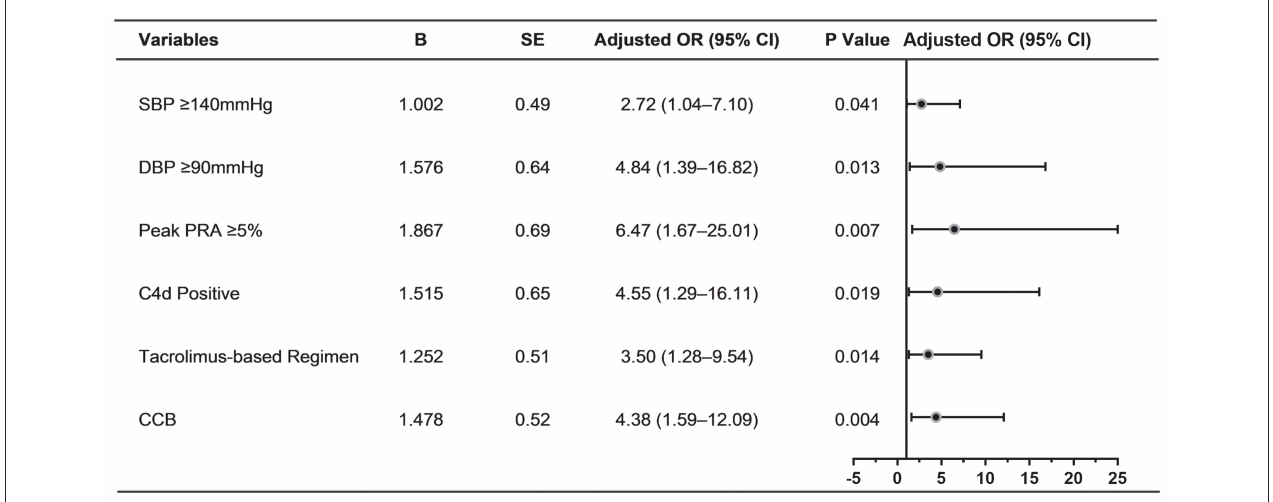
FIGURE 4 | Determinants of proteinuria in multivariable logistic regression analysis ( n = 165). Forest plot displaying odds ratios for proteinuria after multivariable logistic regression analysis. The following variables were included in the multivariable model: Peak PRA ≥ 5%, delayed graft function, SBP ≥ 140 mmHg, DBP ≥ 90 mmHg, CNI regimens, use of ACEI/ARB, use of CCB, positive C4d staining, cg score ≥ 2. SE, standard error; OR, odds ratio; CI, confidence interval; SBP, systolic blood pressure; DBP, diastolic blood pressure; PRA, panel reactive antibody; CCB, calcium channel blocker; CNI, calcineurin inhibitor; ACEI, angiotensin-converting enzyme inhibitor; ARB, angiotensin-receptor blocker.